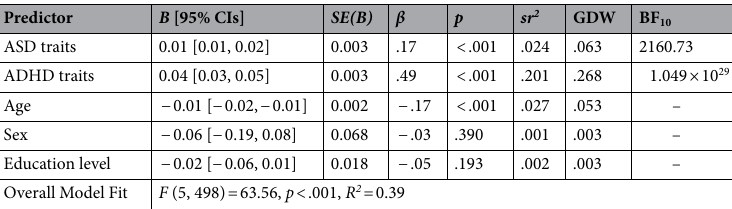
Table 2. Regression, Dominance, and Bayesian Analyses. 95% bias − corrected and accelerated bootstrap confidence intervals for B using 2000 resamples. General Dominance Weight (GDW, with higher values indicating a more important predictor). Sex is coded as 0 = female; 1 =